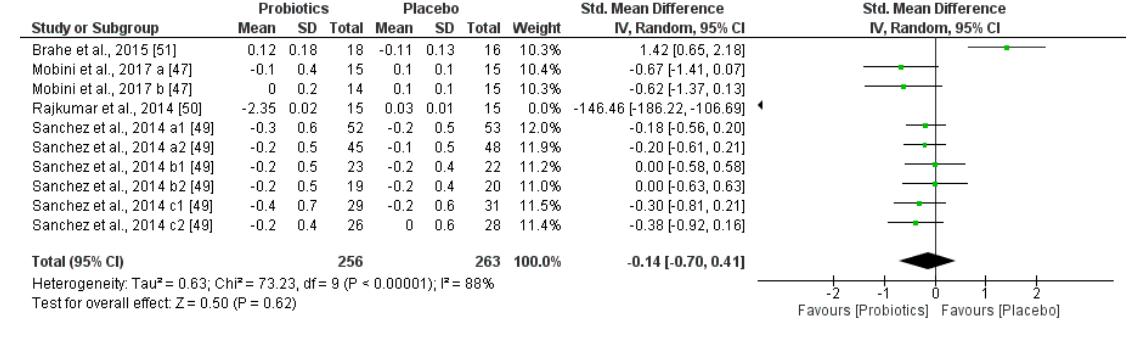
Figure 8. ( A ) Overall effect of probiotics on Body Mass Index (BMI) in selected Clinical Trials (CT). ( B ) Effect of probiotics on BMI in CT with impacting microbiota modifications. ( C ) Effect of probiotics on BMI in CT without impacting microbiota modifications.